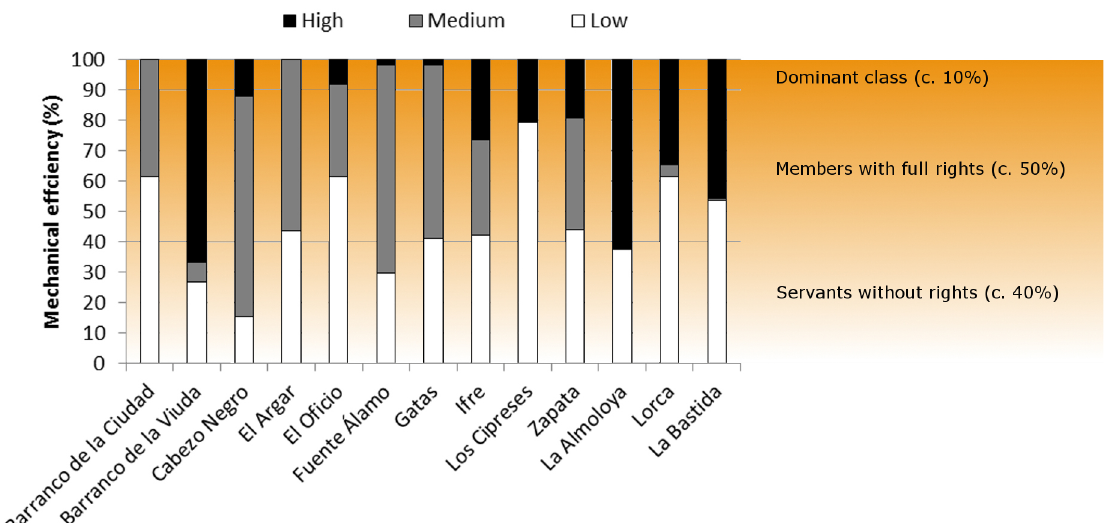
Figure 8. Mechanical efficiency of the grinding slabs inside El Argar settlements projected against the social organisation as seen in the funerary